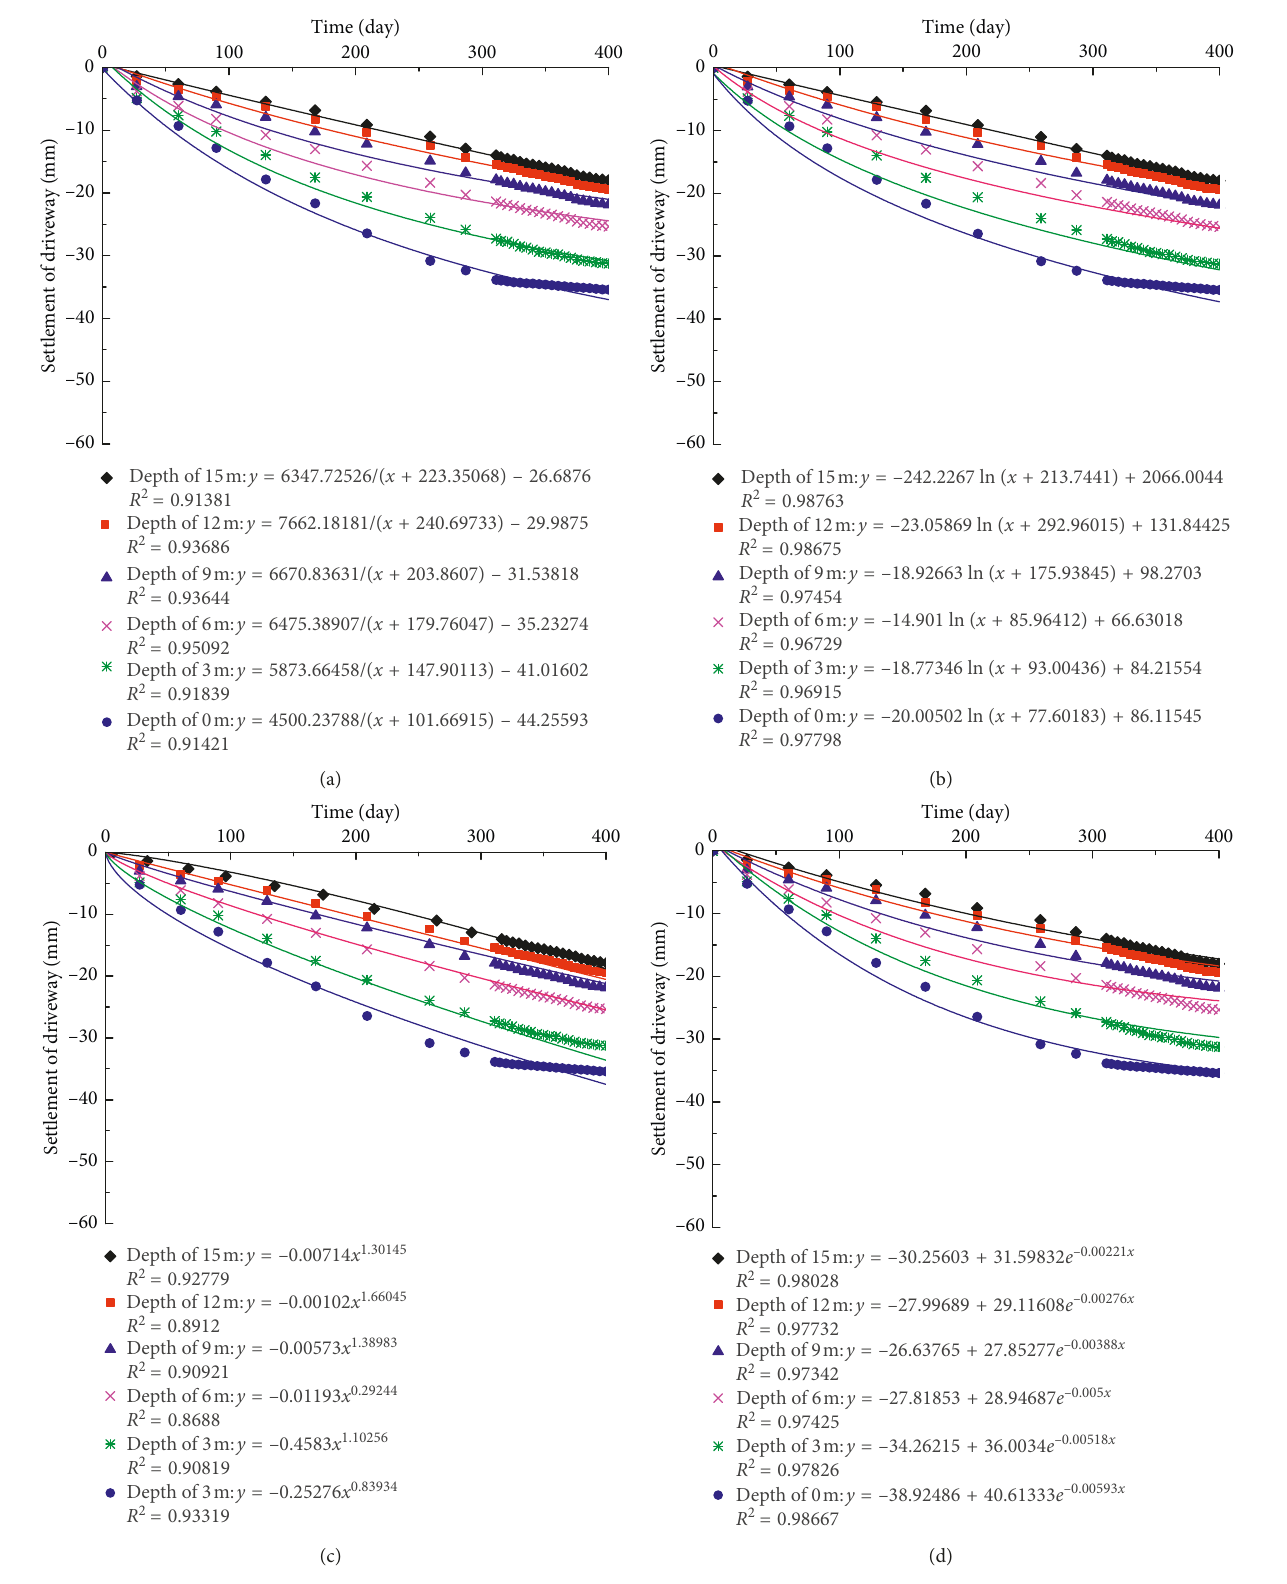
Figure 8: Prediction model for the settlement of driveway: (a) hyperbolic function; (b) logarithmic function; (c) power function; (d) exponential